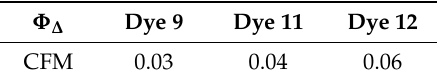
Table 3. Singlet oxygen quantum yield ( Φ ∆ ) of quinoline- and benzoselenazole-derived unsymmetrical squaraine cyanine dyes 9 , 11 and 12 measured in chloroform (CFM) using phenazine ( Φ ∆ = 0.84) as